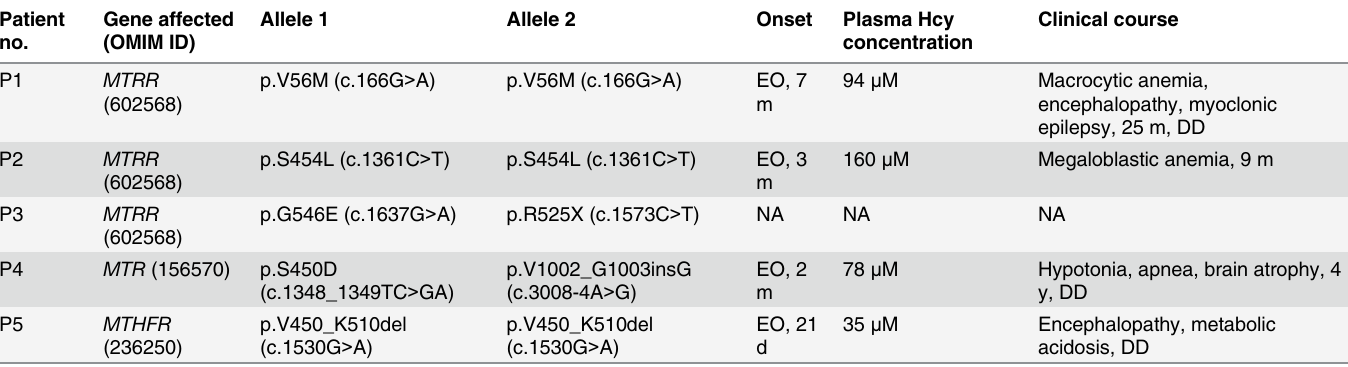
Table 1. Genotype and clinical phenotype in five homocystinuria patients with remethylation defects. Patient